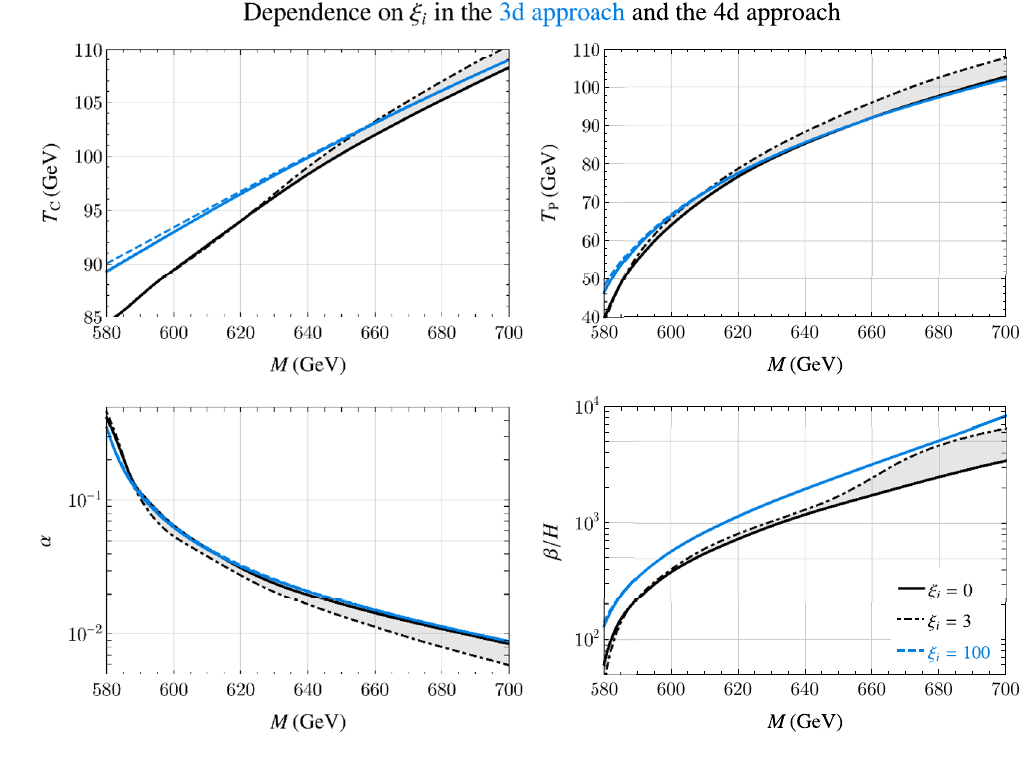
Figure 4 . Gauge dependence of thermal parameters for the 4d approach at ¯ µ = T (black) and the 3d approach at ¯ µ = 2 . 2 T (blue). In both cases the continuous lines denote ξ 1 = ξ 2 = 0 and the dot-dashed lines denote ξ 1 = ξ 2 = 3. At ξ 1 = ξ 2 = 10 the 4d approach breaks down, whereas in the 3d approach the artificial gauge dependence is largely indiscernible, even to very large values of ξ i . A dashed blue line demonstrates this at ξ 1 = ξ 2 = 100 for the 3d approach. Note that the residual gauge dependence in the 3d approach is an artifact of an incomplete operator basis in this EFT, and as such is not morally equivalent to the inherent gauge dependence in the 4d